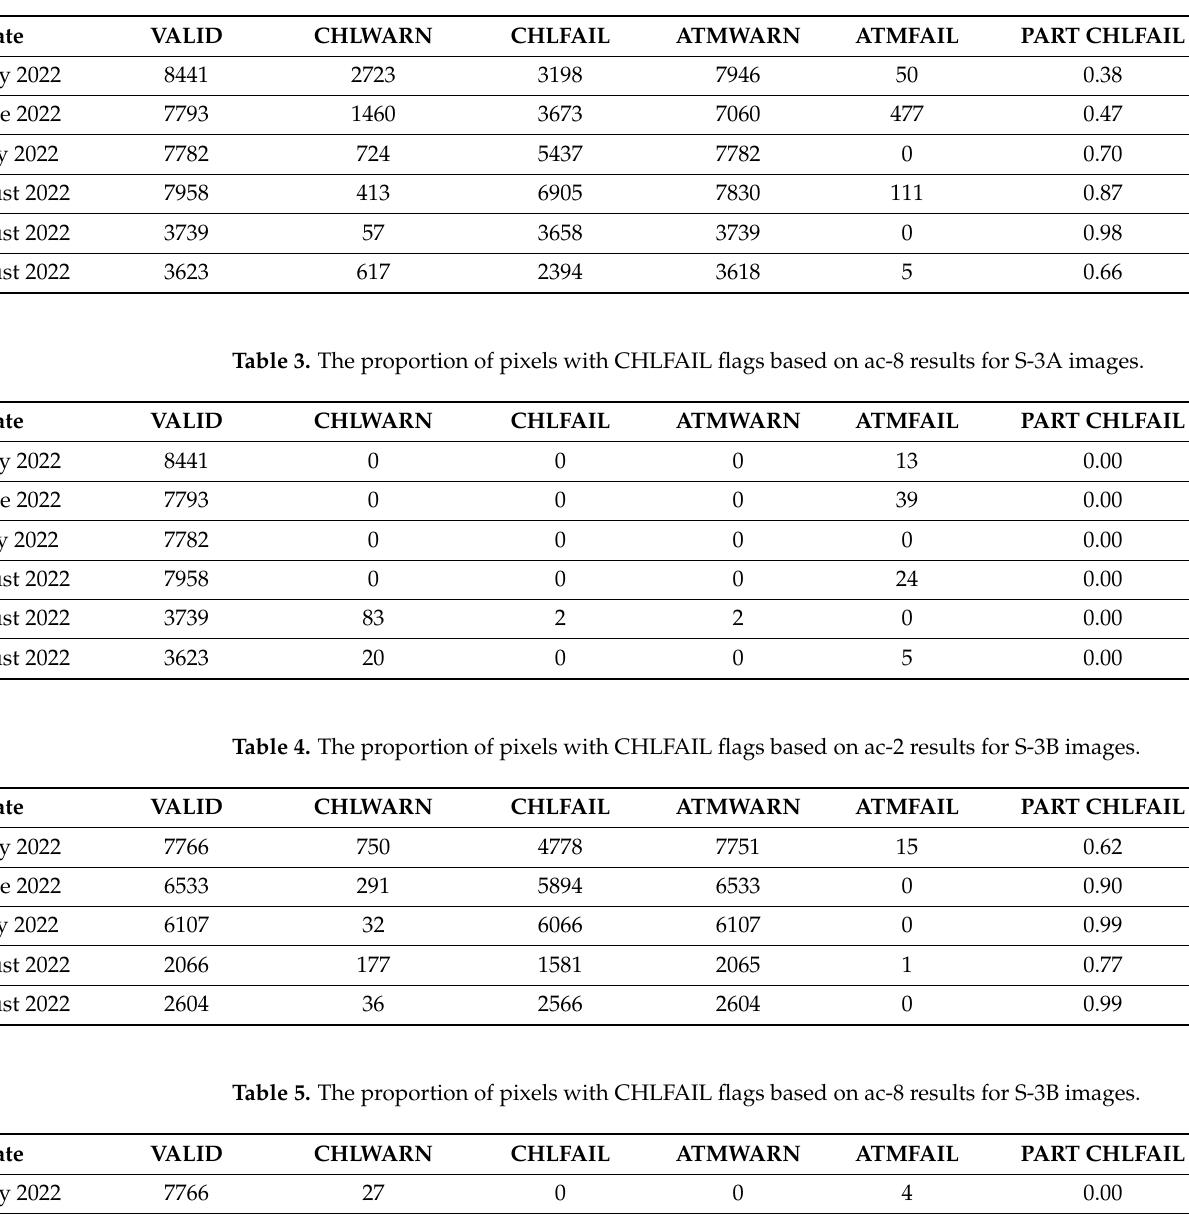
Table 2. The proportion of pixels with CHLFAIL flags based on ac-2 results for S-3A images.